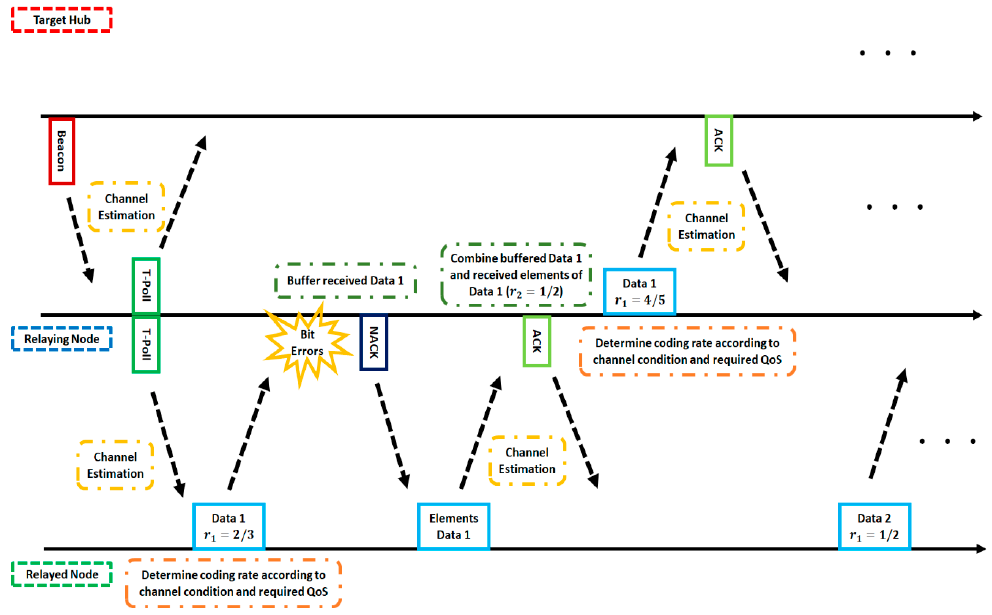
Figure 8. Operation example of Scheme 2. ACK, NACK, and QoS are abbreviations of acknowledgement, negative-acknowledgement, and quality of service